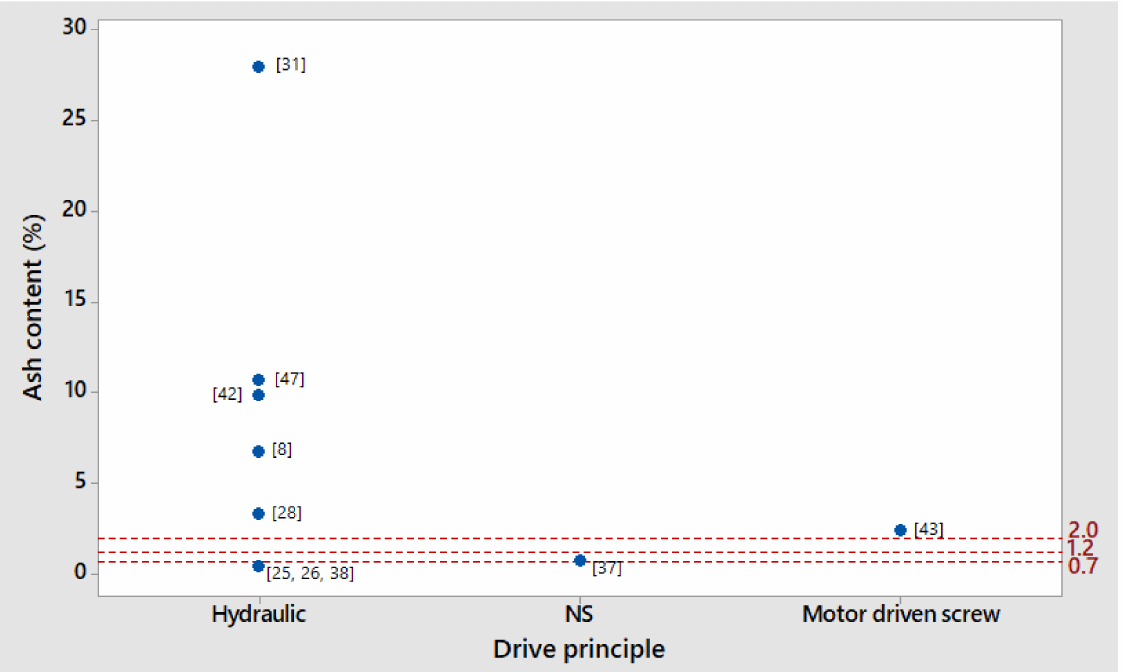
Figure 7. Relationship between the individual values of the ash content (AC) with the principle of operation of the briquetting